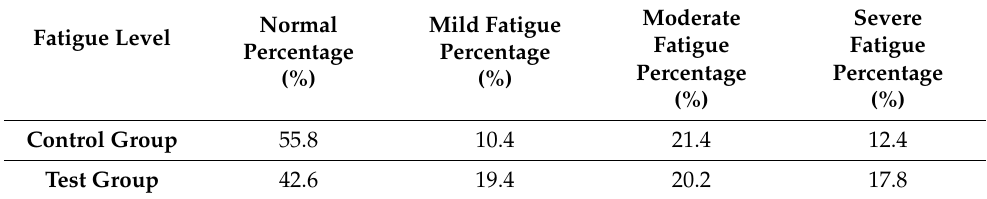
Table 4. Fatigue status of the experimental